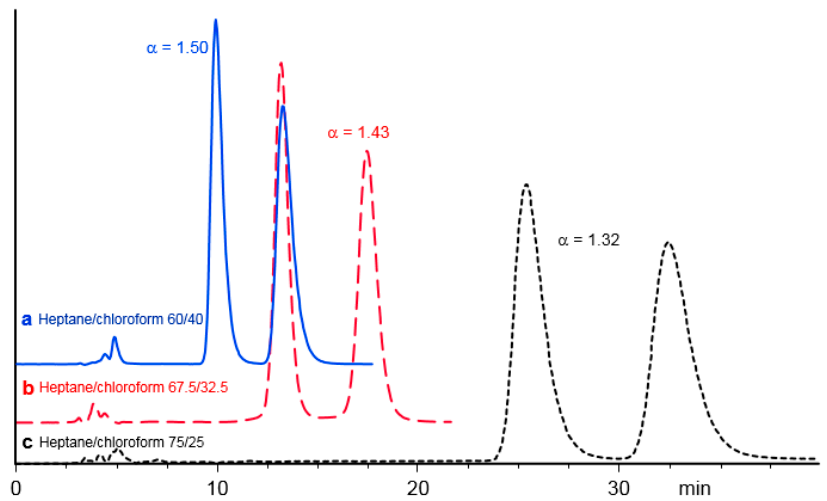
Figure 7. Chromatographic resolution of compound 6 on PMBC-Im E using heptane /chloroform mixtures as a mobile phase: ( a ) 60/40 ( v/v ); ( b ) ----- 67.5/32.5 ( v/v ); and ( c ) …… 75/25 ( v/v ).